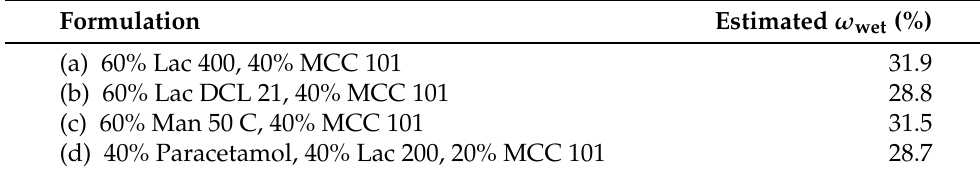
− 3 for different